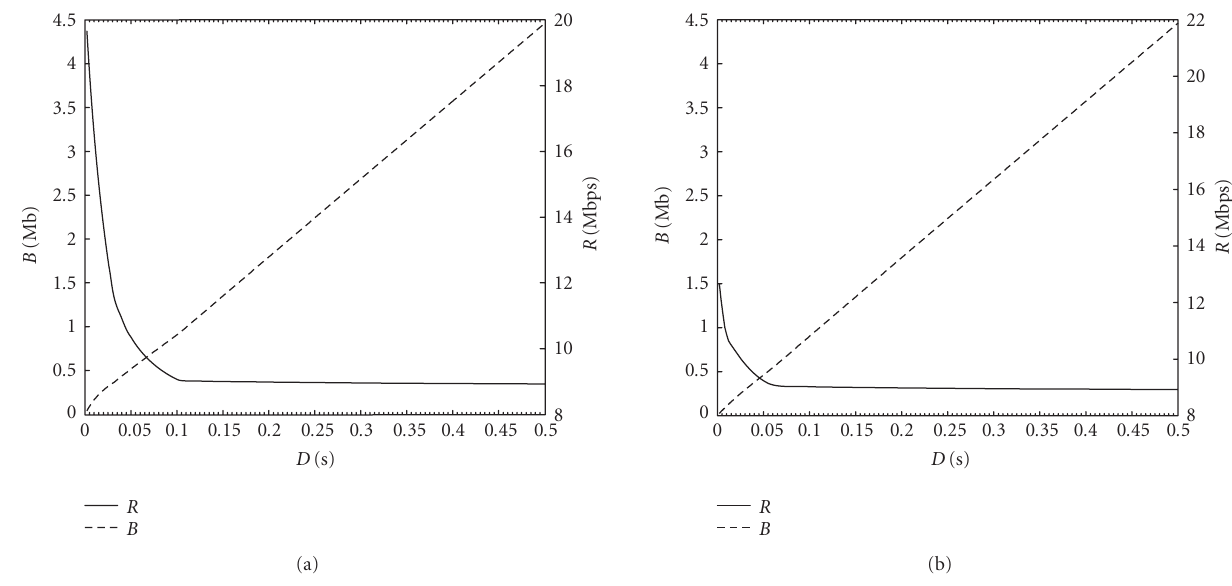
Figure 5: Dimensioning for (a) 24-hour MAWI tra ffi c and (b) 1-hour MAWI tra ffi